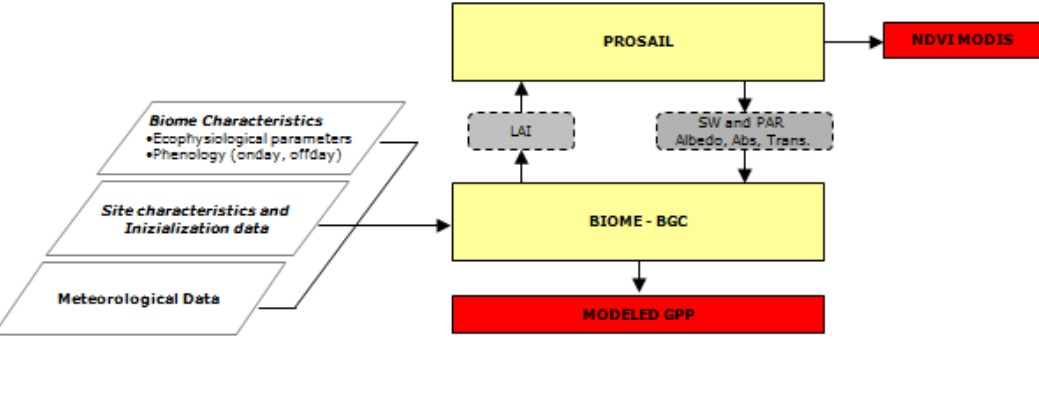
Figure 1. Flow chart of the PROSAILH-BGC model. Yellow blocks represent the models, parallelepipeds represent the input parameters, grey boxes represent the state variables passed between the coupled models, while the red boxes are the model outputs (NDVI and